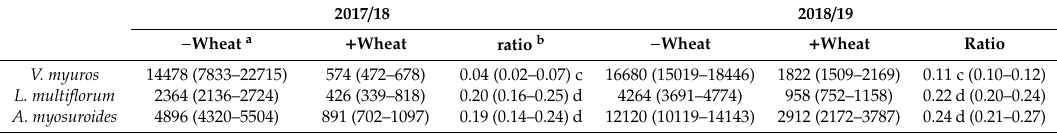
Table 4. Mean per plant seed production and ratio of seed production of annual grass weeds in the presence and absence of winter wheat. For grass species with the same labels (c and d) indicate that the ratio did not di ff er significantly. 95% bootstrap confidence intervals are given in